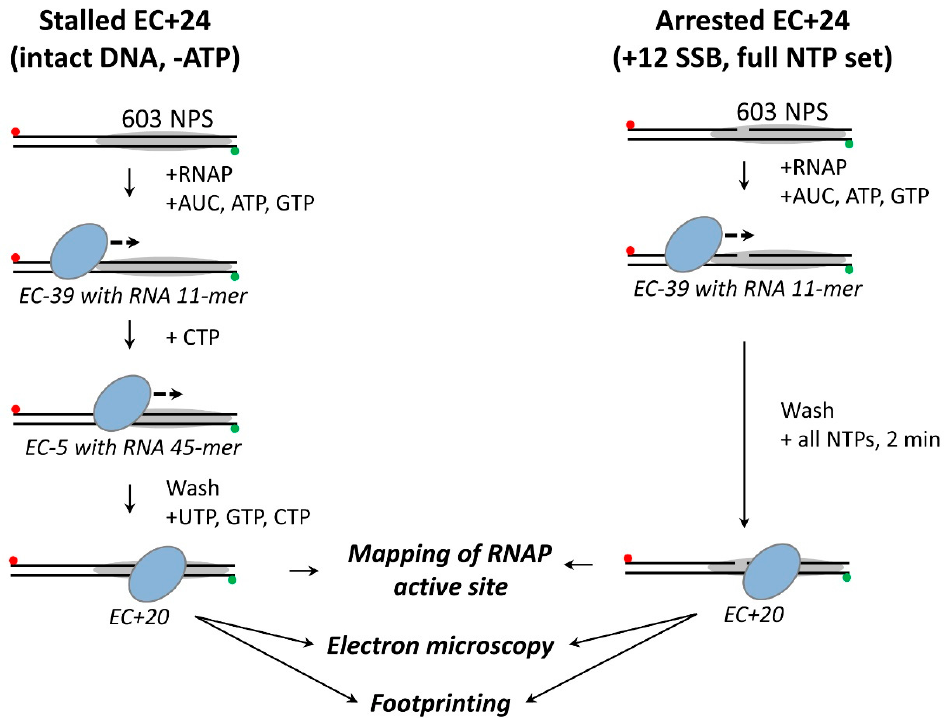
Figure 1. Structural analysis of elongation complexes stalled or arrested in nucleosome. Positioned nucleosomes were assembled on fluorescently labeled 603 DNA containing ROX and fluorescein at the 5 ′ -ends of template and non-template DNA strands (indicated by red and green circles, respectively) containing intact DNA or a single ssDNA break after 12th nucleotide of non-template strand from the nucleosomal boundary, and transcribed for a limited time to form stalled (without the nick) or arrested (with the nick) elongation complex EC+20 (the numerical index indicates position of the active site of the enzyme from the nucleosomal boundary). The complexes were treated by DNase I or by hydroxyl radicals, and analyzed by denaturing PAGE. In parallel, the same samples were analyzed by electron microscopy, or position of the active center of the enzyme was mapped using RNA cleavage factor GreB. 603 NPS–603 nucleosome positioning sequence [44,66]. Histone octamer and RNAP are shown by grey and blue ovals, respectively. Direction of transcription is indicated by dashed arrow.